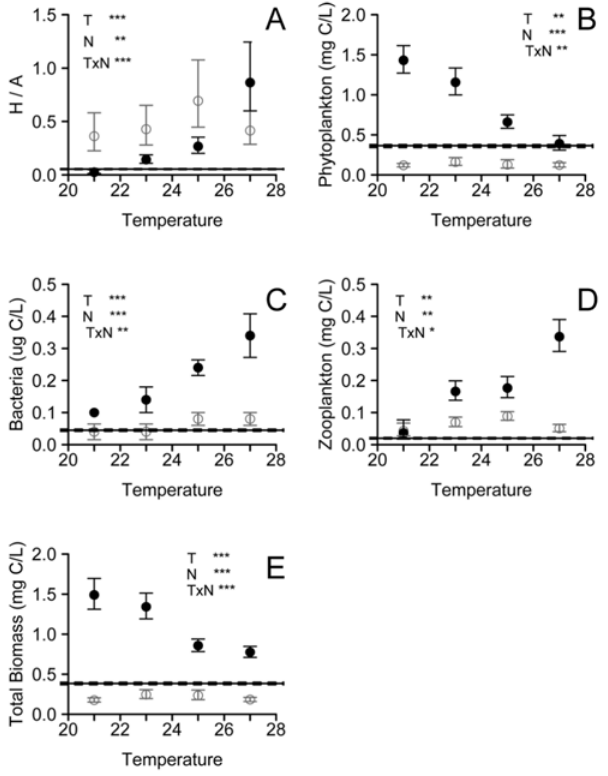
Figure 2. Effects of temperature and nutrient treatments on food web structure and biomass . Effect of temperature ( u C) on mean ( 6 s.e.) (A) ratio of heterotroph to autotroph biomass and the N carbon biomass of (B) phytoplankton, (C) microbes, (D) zooplankton, ) and control ( # ) and (E) the entire food web in nutrient addition ( treatments. Initial conditions (mean 6 s.e. indicated by horizontal lines) mimicked contemporary conditions in Bogue Sound. Significance of two-way ANOVA test: *** p , 0.001, ** p , 0.01, * p , 0.05. Full statistical results in Table 2.